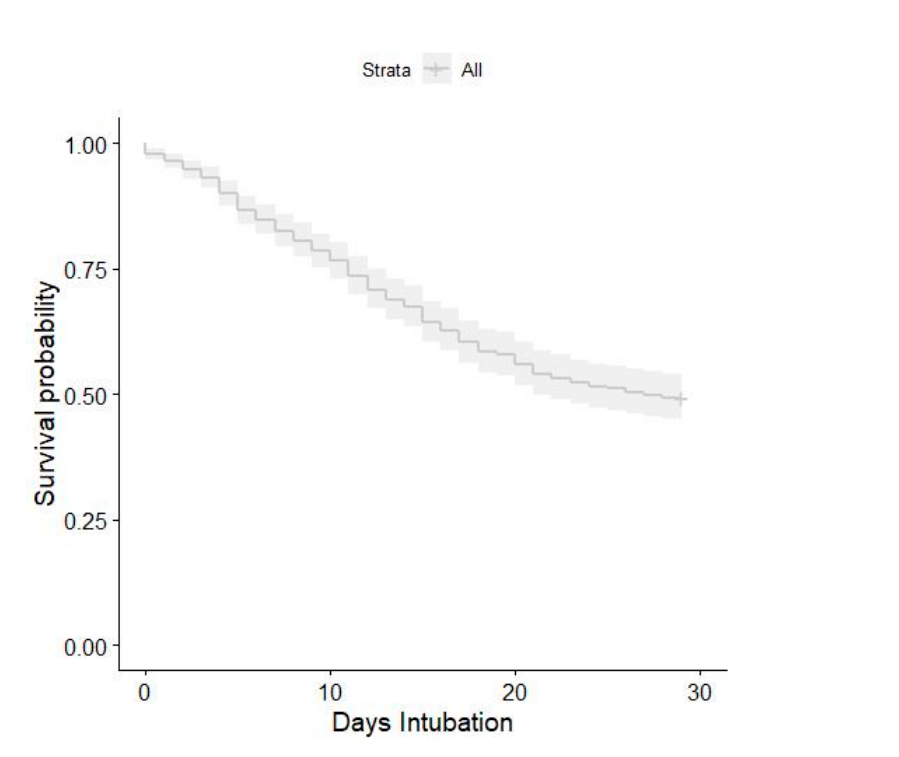
Figure 3. Kaplan–Meier survival plot for 28-day mortality in relation to intubation time after the 4C score at admission adjustments.